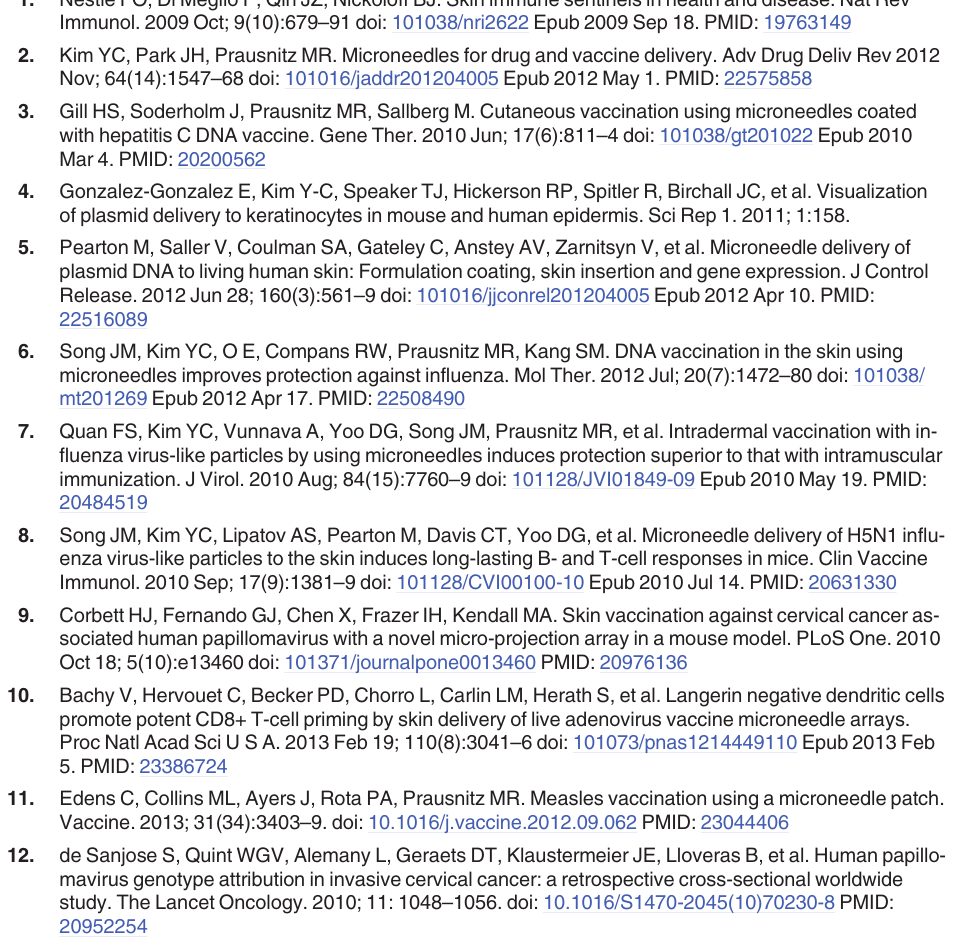
S3 Fig. Protection from HPV challenge one month after a single administration of HPV16 PsV. Data showing cervicovaginal challenge of animals described in Fig. 3 one month after ad- ministration of PsV by either scraping, disruption with bifurcated needle or microneedles. 10 8 IU of HPV16-Luc was administered and animals were imaged 48hrs later for luciferase activity. The “ No PsV ” group was not challenged in order to serve as a negative control group for lumi- nescence. Data reported as average radiance; n = 2.